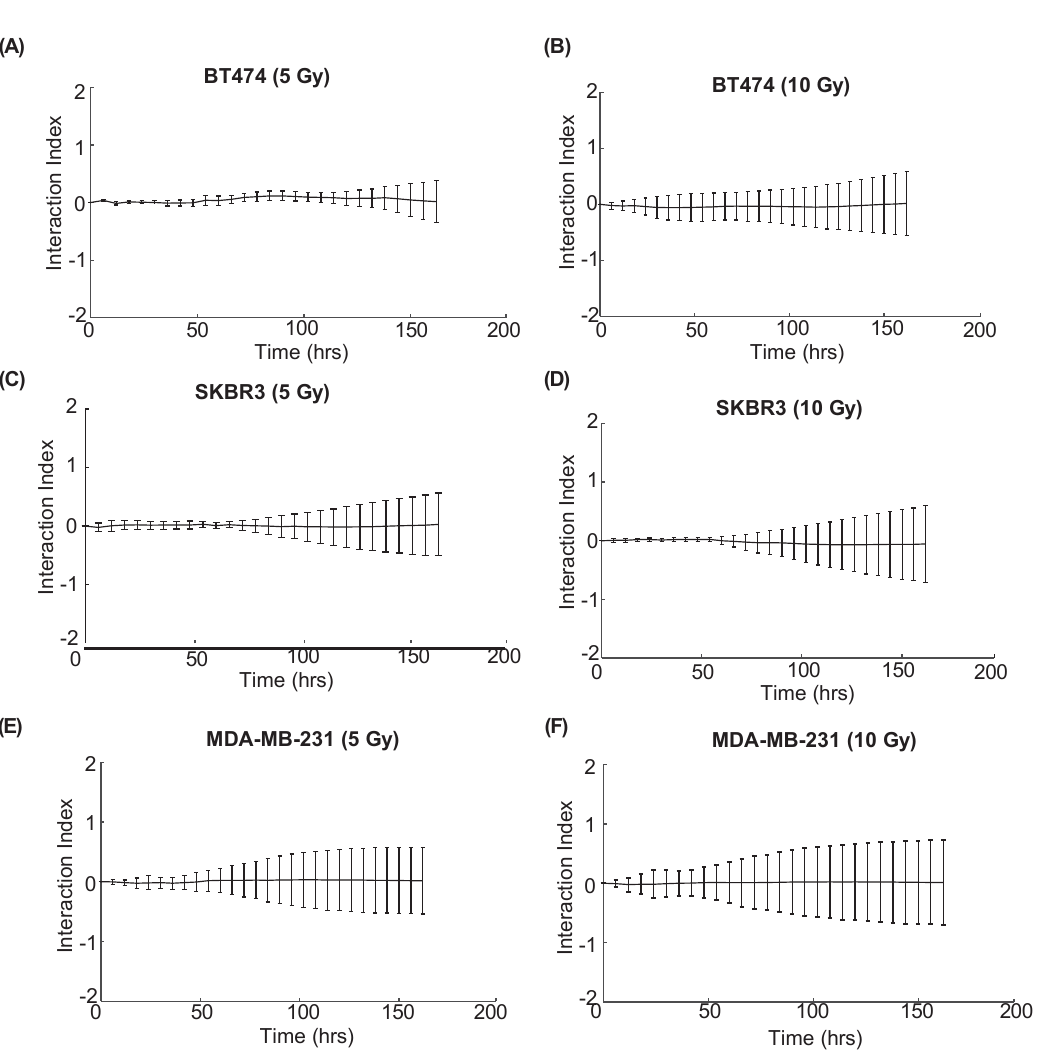
Figure 5. Interaction index calculated per time point over one week of treatment. All groups were treated with 0.01 ng/mL of trastuzumab. Graphs display the interaction indexes of ( A ) BT474 cells with 5 Gy radiation and trastuzumab; ( B ) BT474 cells with 10 Gy radiation and trastuzumab; ( C ) SKBR3 cells with 5 Gy radiation and trastuzumab; ( D ) SKBR3 cells with 10 Gy radiation and trastuzumab; ( E ) MDA-MB-231 cells with 5 Gy radiation and trastuzumab; and ( F ) MDA-MB-231 cells with 10 Gy radiation and trastuzumab. No group had an interaction index significantly above or below 0 at any time point, indicating additive treatment effects.